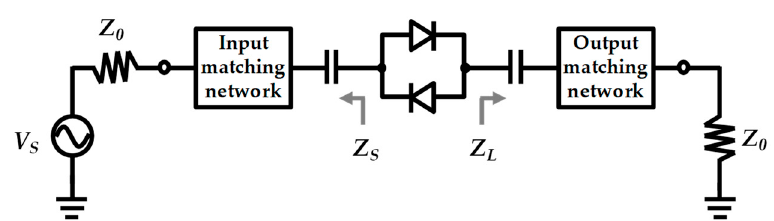
Figure 3. Source ‐ and load ‐ pull simulations of anti ‐ parallel diode pair.